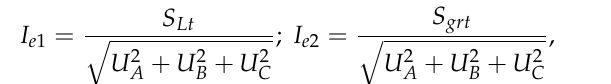
Figure 26. Evolution of the relative decrease of electrical losses upstream of the connection point, during the recordings (p.u.).